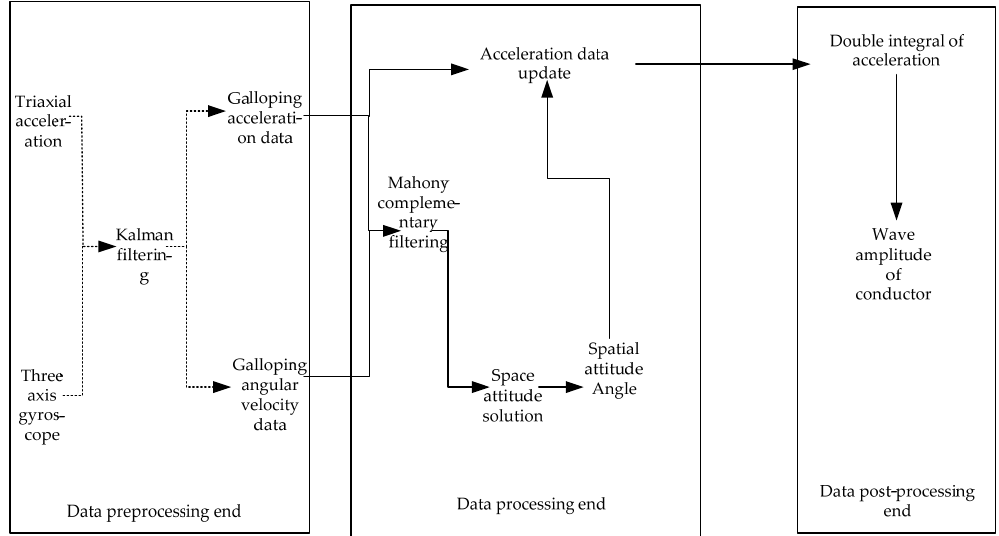
Figure 7. Schematic diagram of the design of the galloping attitude calculation algorithm.